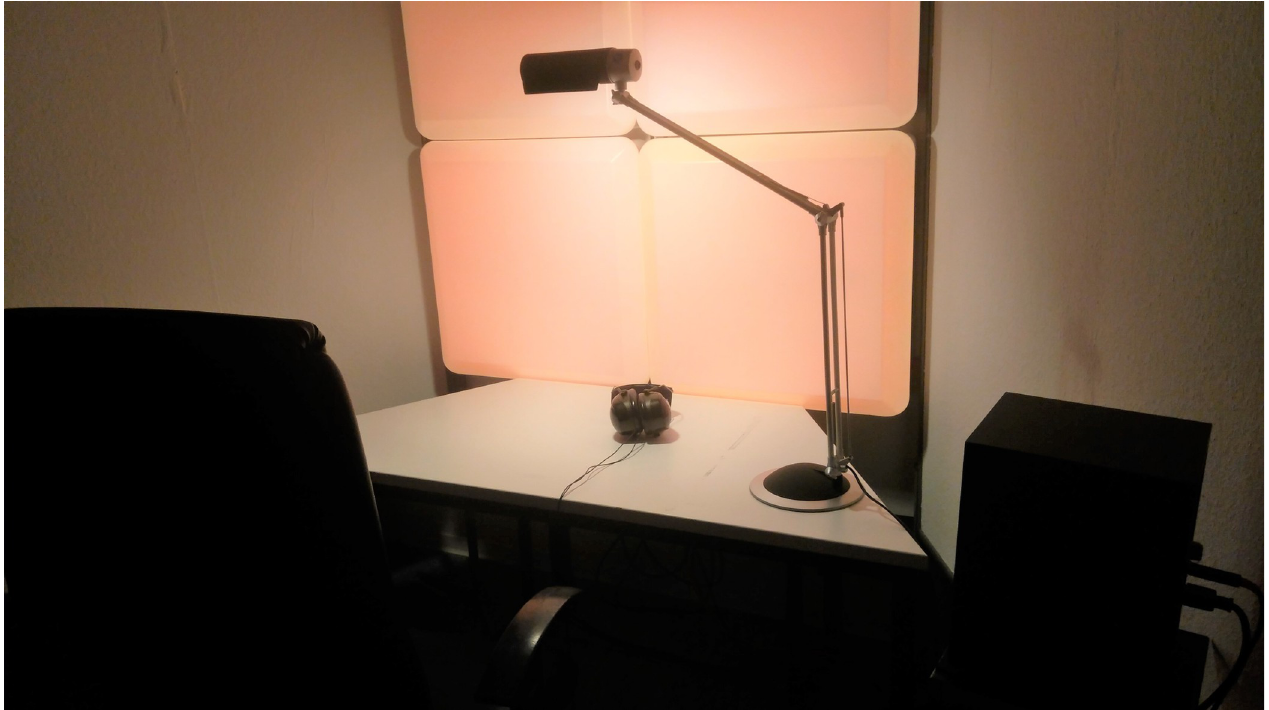
Fig 1. The experimental setup. The LED wall emitted a slightly reddish light creating a comfortable atmosphere, a table lamp facilitated reading in the otherwise dark room.